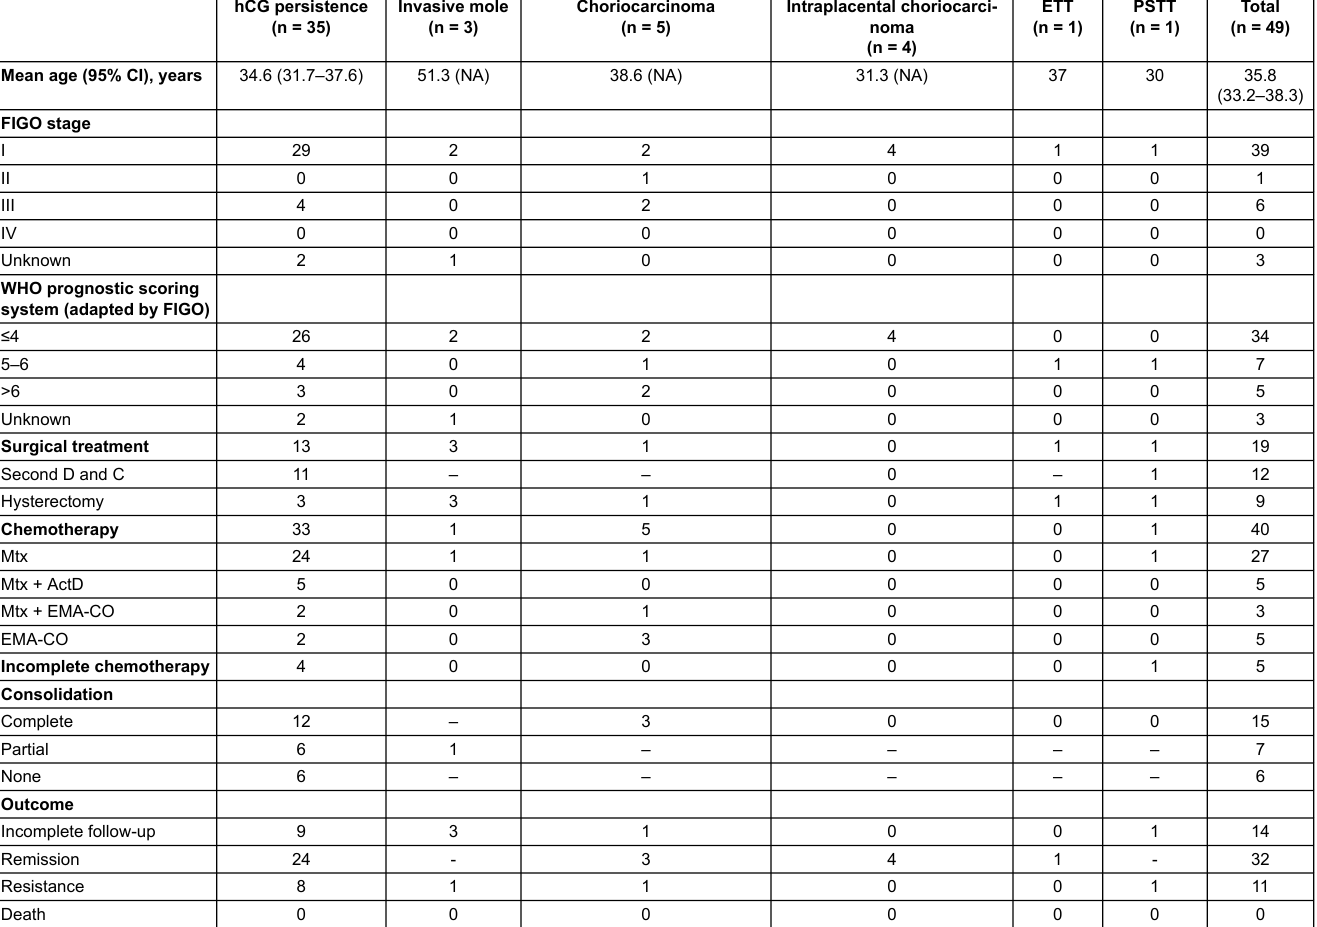
WHO prognostic scoring system (adapted by